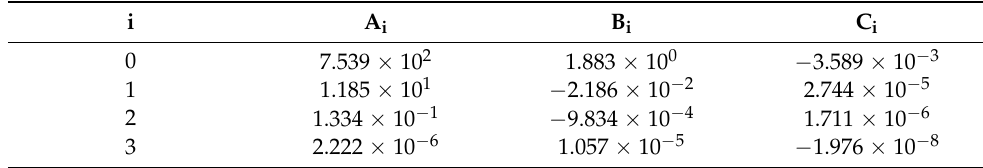
Table A8. Coefficients of the H 2 O-LiI density